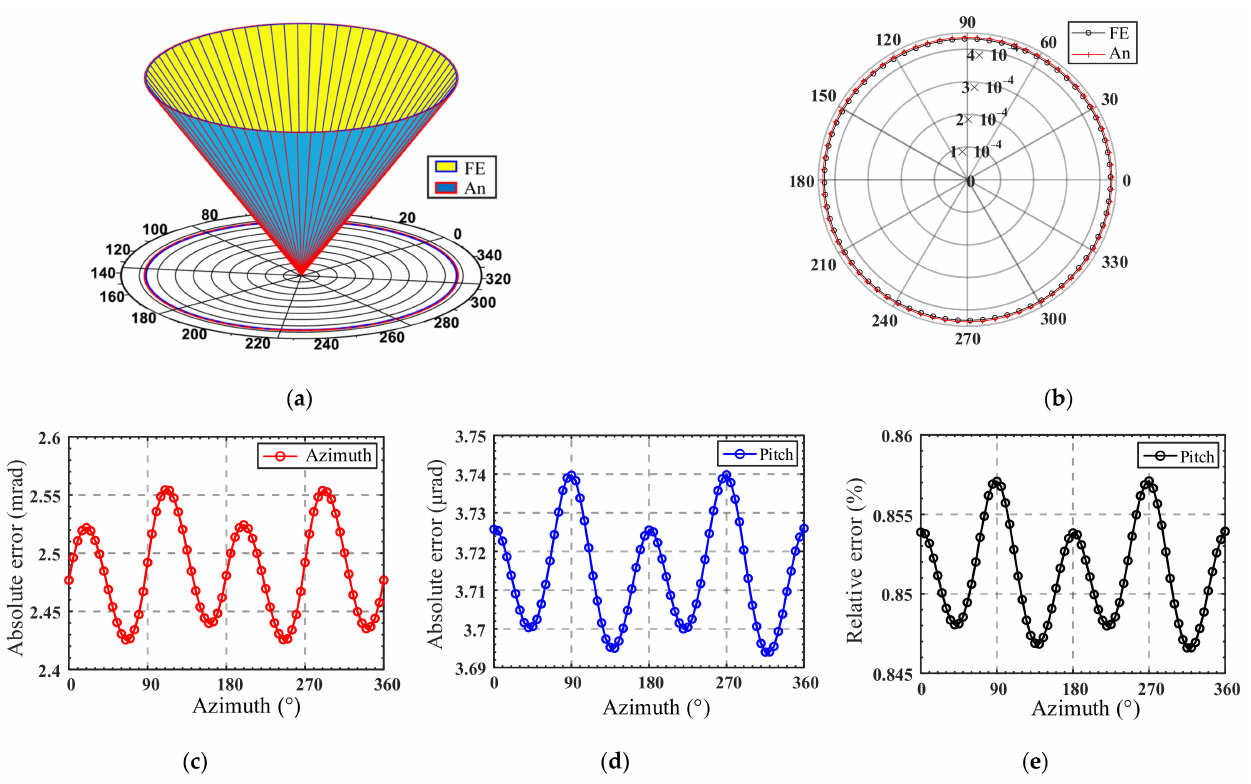
Figure 15. ( a ) Comparison between analytical and FE results of spatial pointing; ( b ) comparison between analytical and FE results of azimuth and pitch; ( c ) absolute error of azimuth; ( d ) absolute error of pitch; ( e ) relative error of